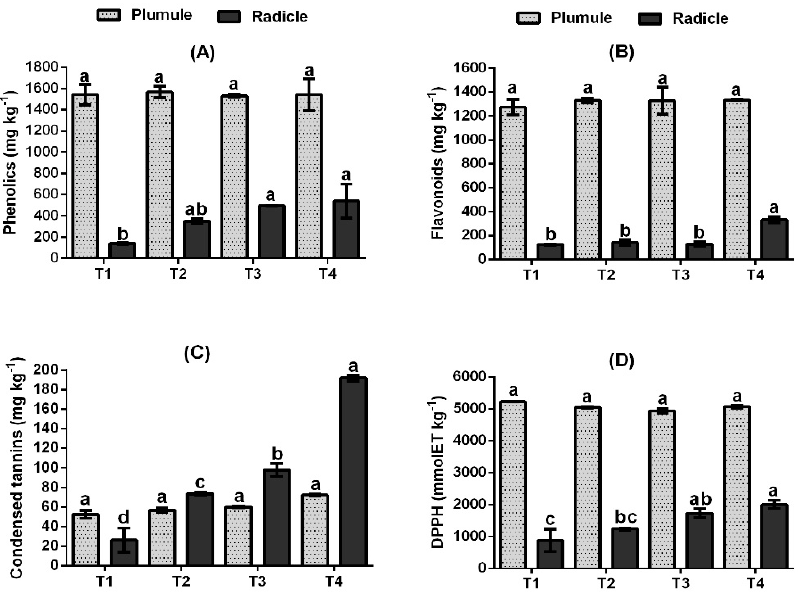
Figure 4. Phenolic content in Capsicum annuum L. seedlings treated with ZnO NPs. ( A ) Total phenols, ( B ) Flavonoids, ( C ) Condensed tannins ( D ) Antioxidant capacity (DPPH) (millimole equivalents of Trolox per kilogram of sample (mmolET kg − 1 ). Values are the average of four repetitions. Means ( n = 4), bars represent the standard deviation of the mean; Different letters are statistically different (Tukey, p ≤ 0.05) and represent the differences between treatments.